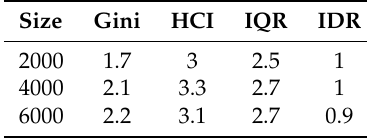
Table 2. Relative mean bias (%) of each parameter applying PSA with the stratified reference sample.